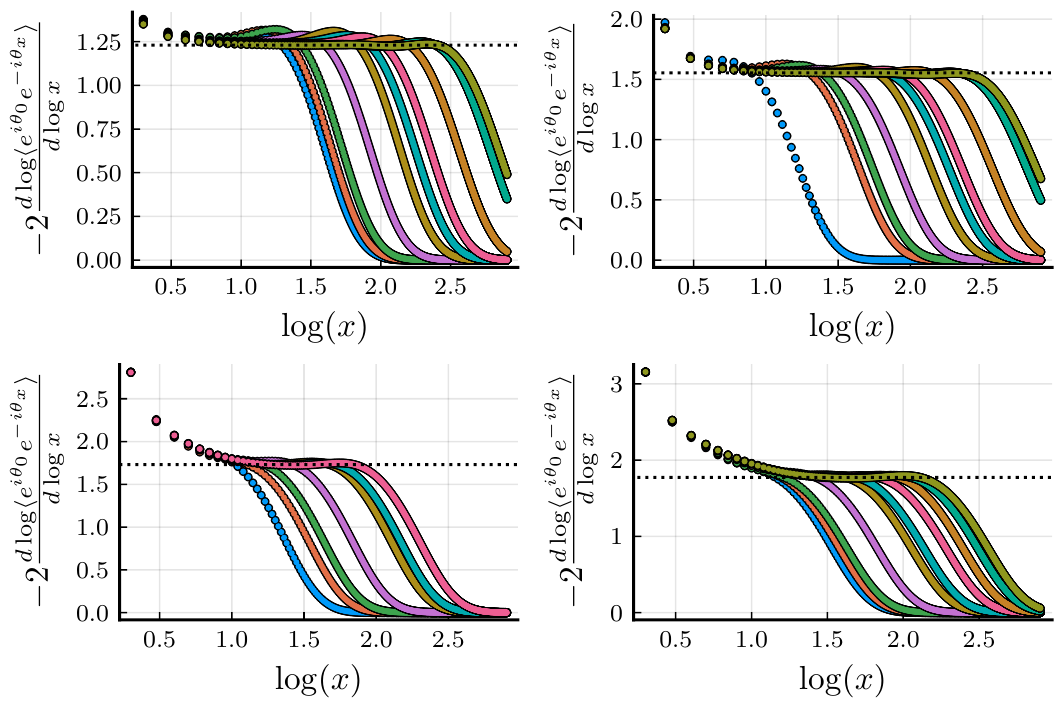
Figure 7 . The logarithmic derivative of the two-point function for various points ( g 2 (6 . 22 , 1 . 52) top-left, (1 . 05 , 0 . 57) top-right, (0 . 56 , 0 . 42) bottom-left and (0 . 47 , 0 . 37) bottom-right, close to the phase transition. The dotted lines indicate the value of the plateau and the corresponding extrapolated value of K . The bond dimensions used in these simulations range up to 2500 for the g 2 ≈ 0 . 47 point. The color coding is the same as in figure 6 . x